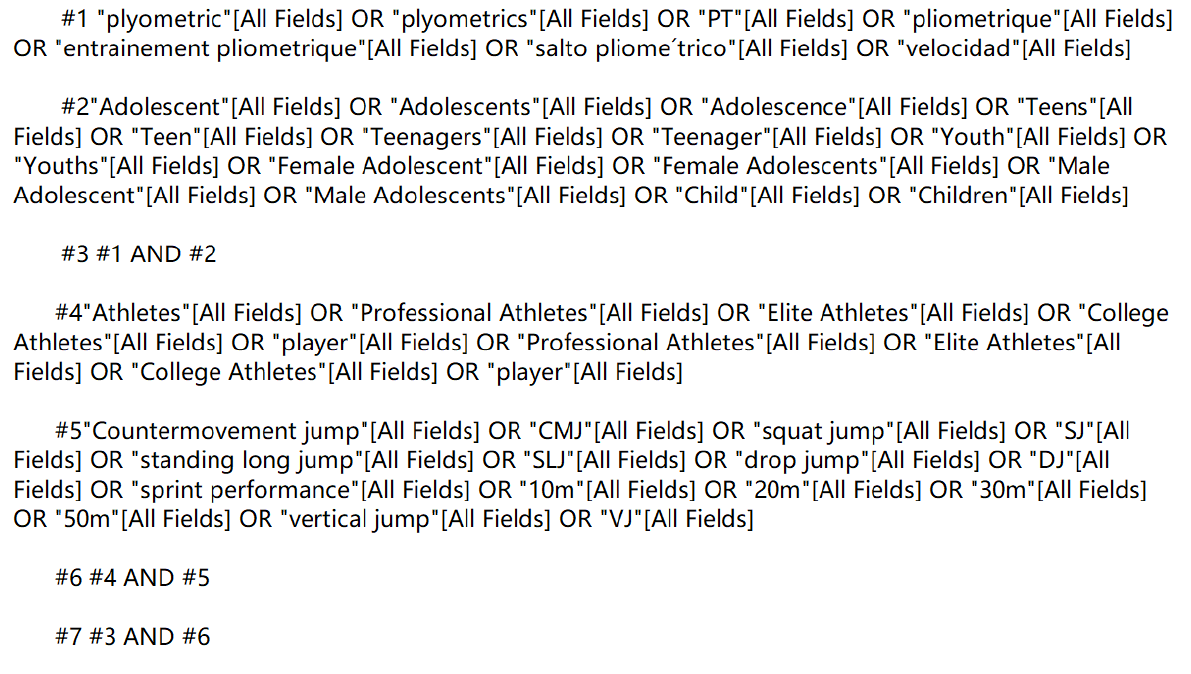
Figure 1. PubMed Literature Selection Strategy.